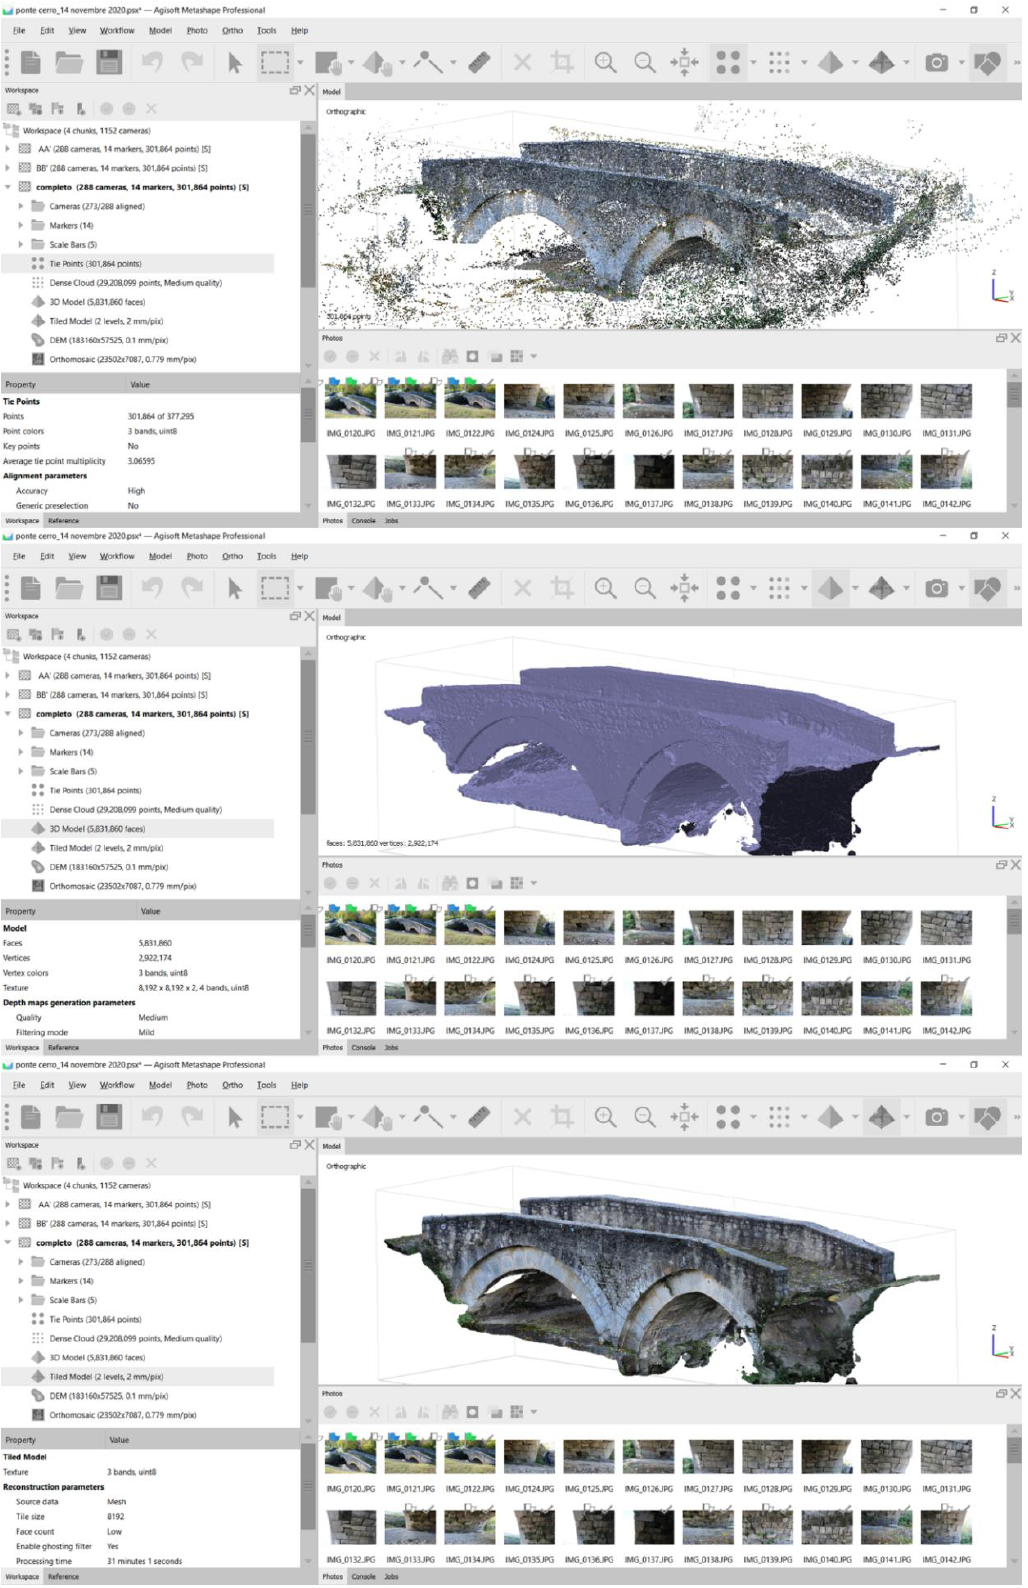
Figure 7. Phases of preparation of the photogrammetric model in Metashape software.